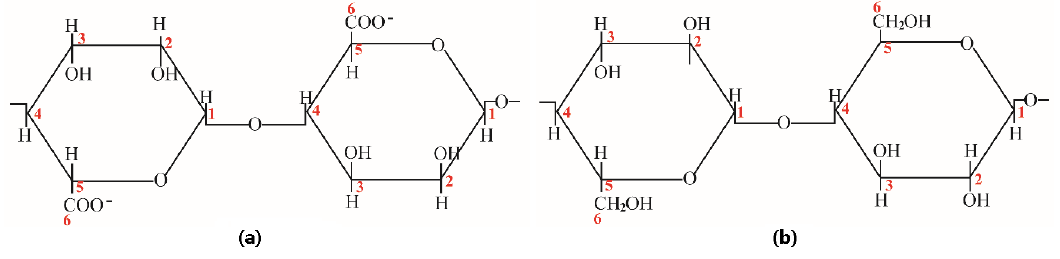
Figure 1. Chemical structure of alginate ( a ) and cellulose ( b ).